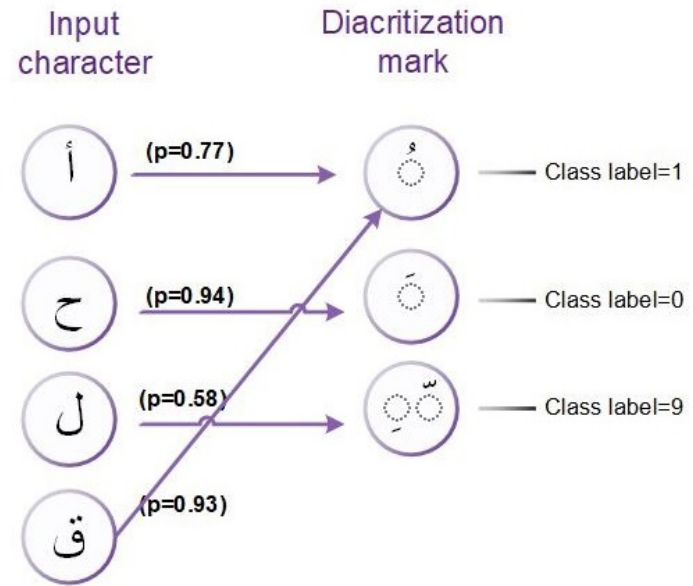
Figure 13. Example of how DBN probabilistically classify